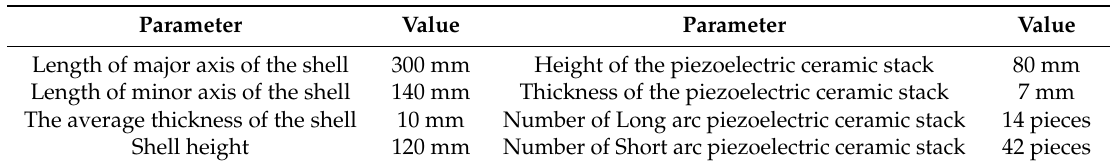
Table 2. Structural sizes of conventional Class IV FT.